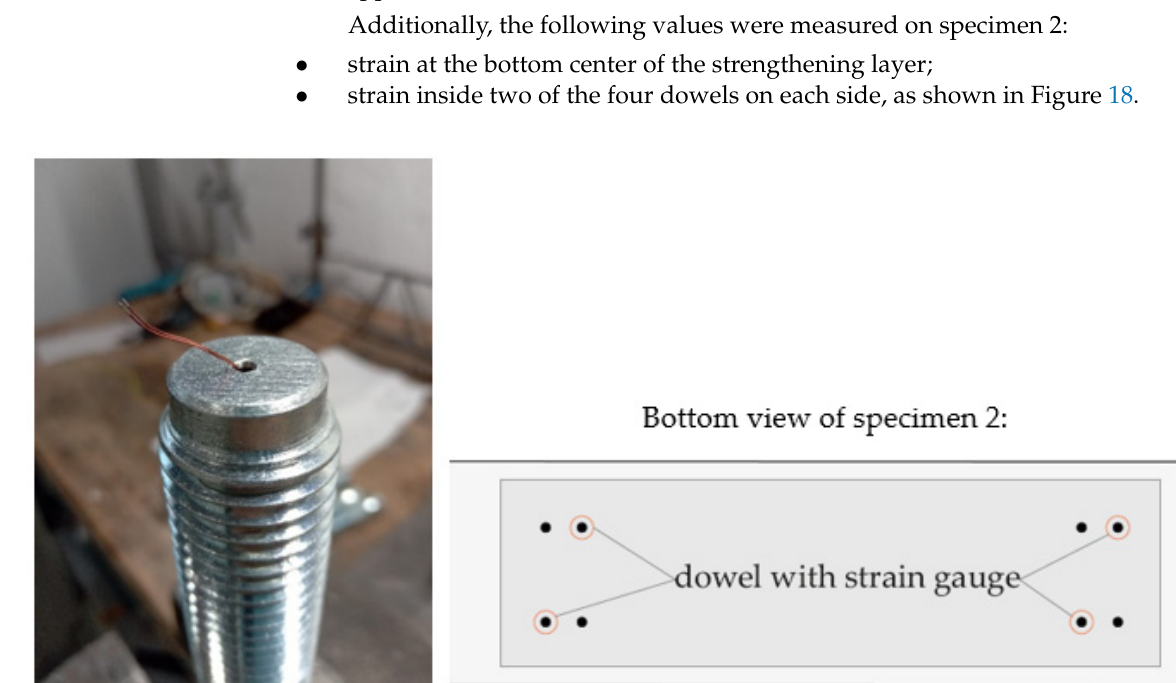
Figure 18. Anchor bolts with strain gauge. (Photo: HTWK Leipzig).